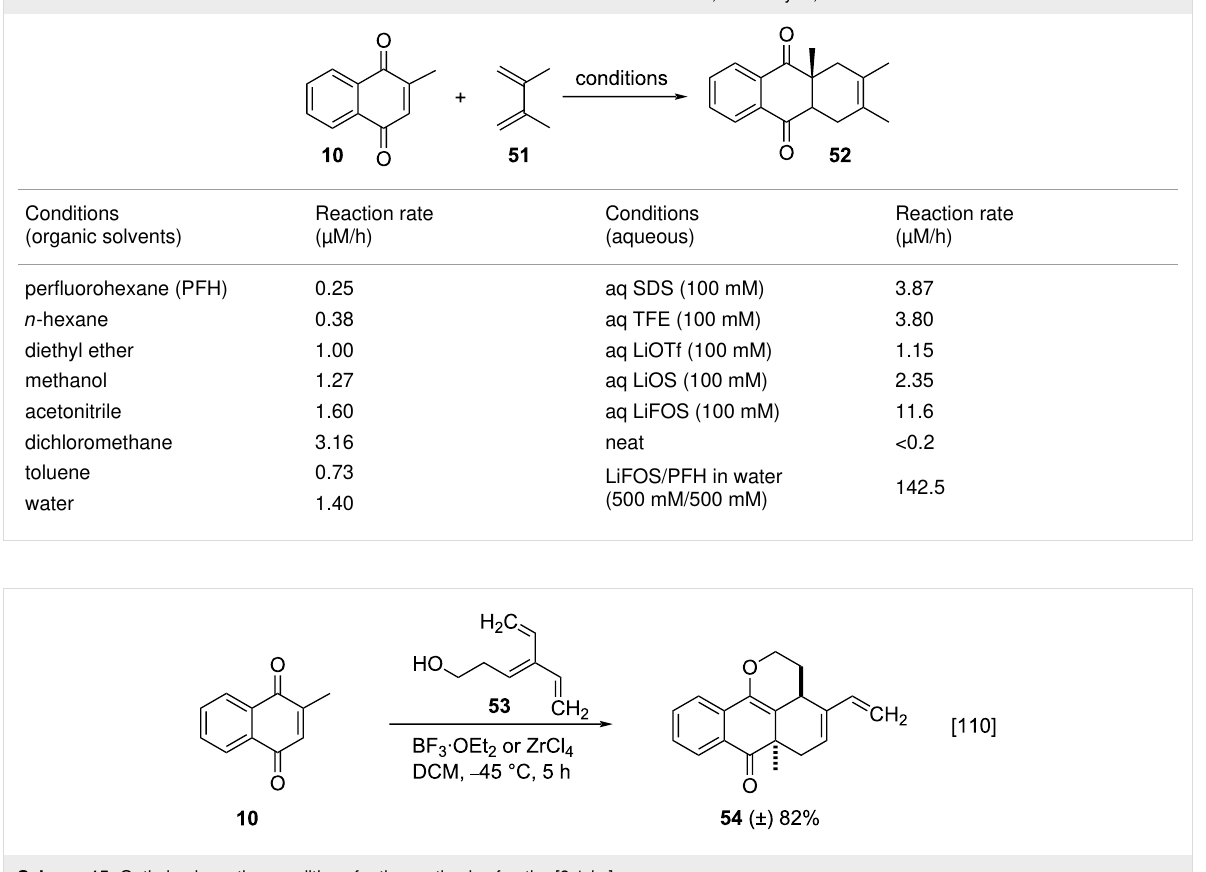
Table 4: Media effect in the initial rates of Diels–Alder reaction between menadione and 2,3-dimethyl-1,3-butadiene.